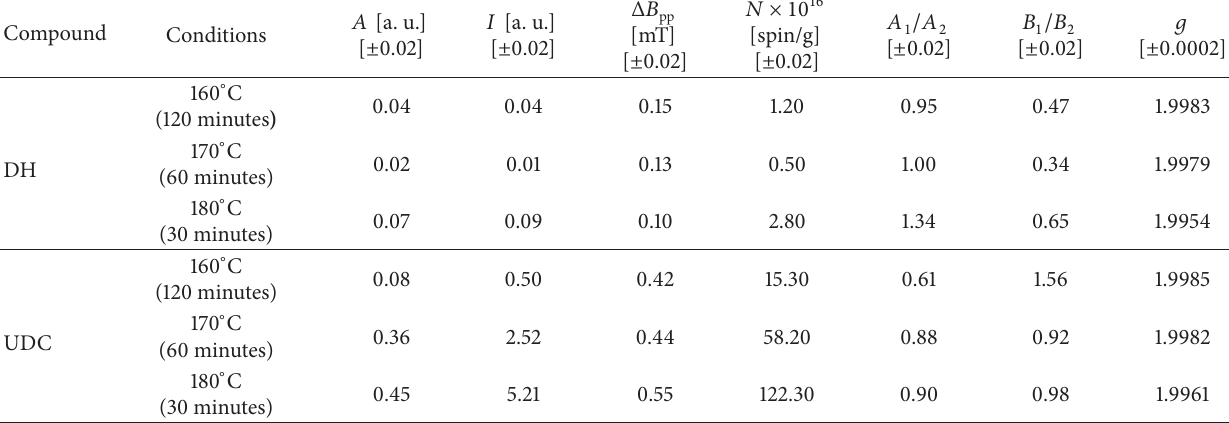
Table 2: Parameters of the EPR spectra of thermally sterilized dehydrocholic acid (DH) and also ursodeoxycholic acid (UDC). Compound